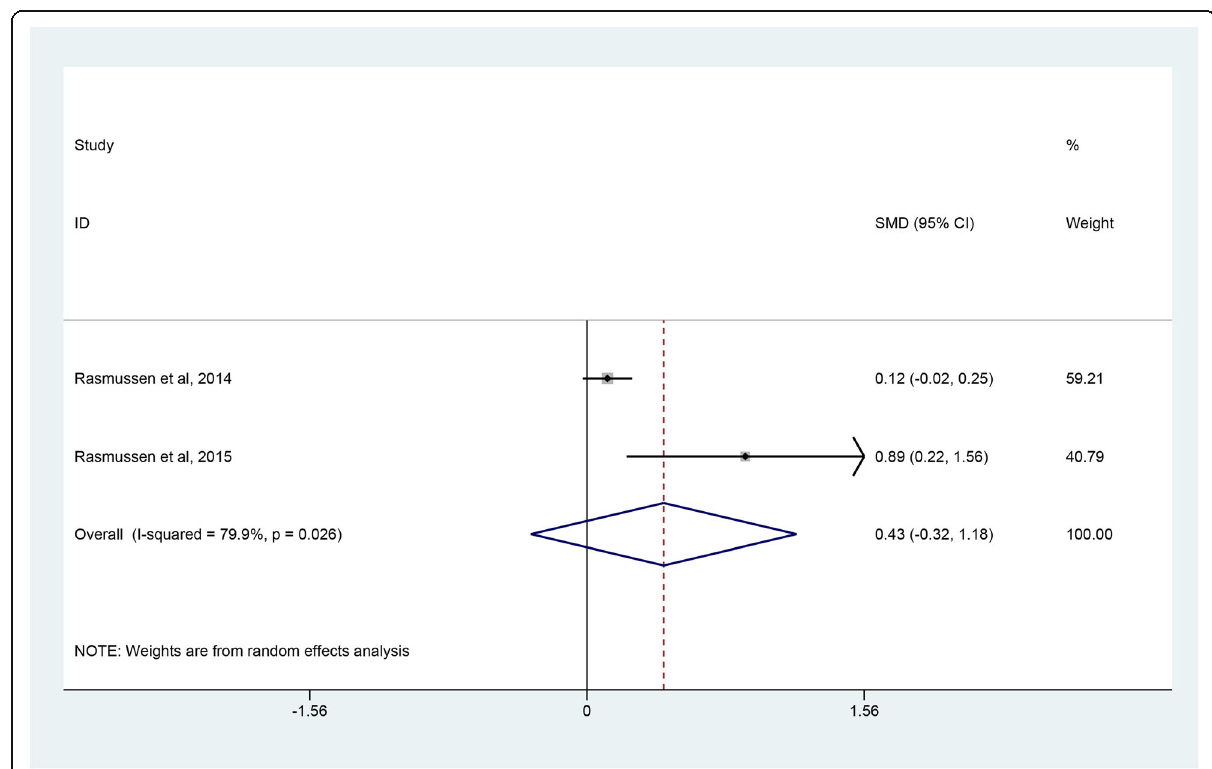
Fig. 5 Forest plot comparing WOOS scores after resurfacing hemiarthroplasty (RHA) versus stemmed hemiarthroplasty